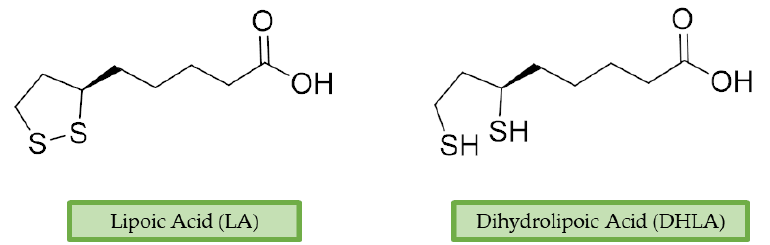
Figure 4. Lipoic acid (LA) and its reduced form, dihydrolipoic acid (DHLA).